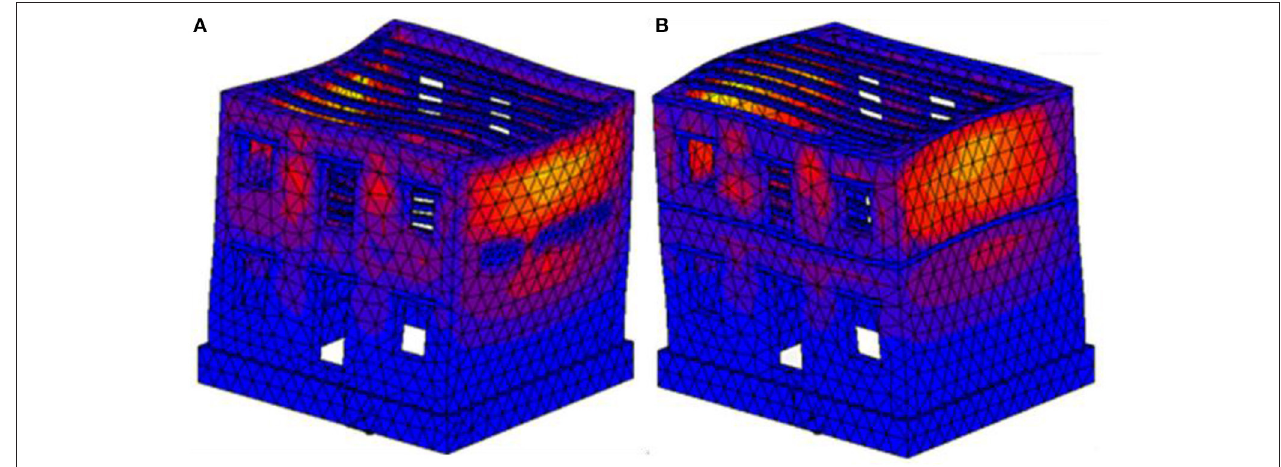
FIGURE 5 | First eigenmode for: (A) the model in its initial state, and (B) the retrofitted model.